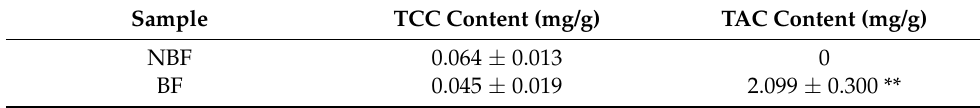
Table 2. Variance differences in TCC and TAC.